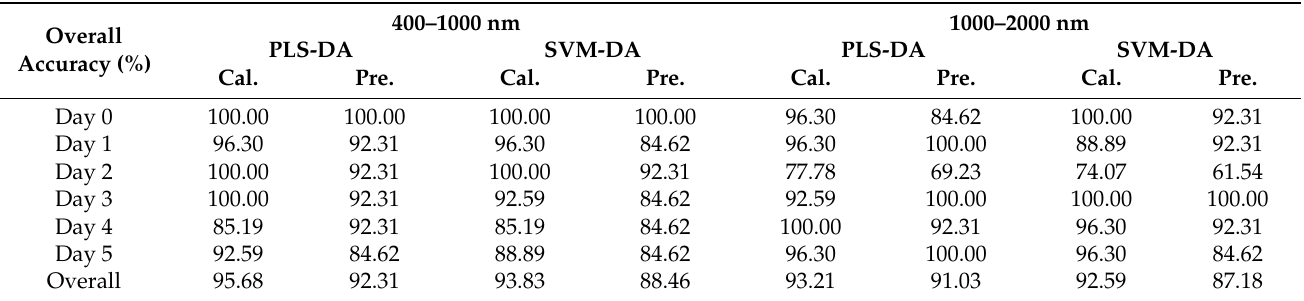
Table 3. Result of classification models based on SNV pre-treated HSI spectral in Vis-NIR (400–1000 nm) and SWIR (1000–2000 nm)